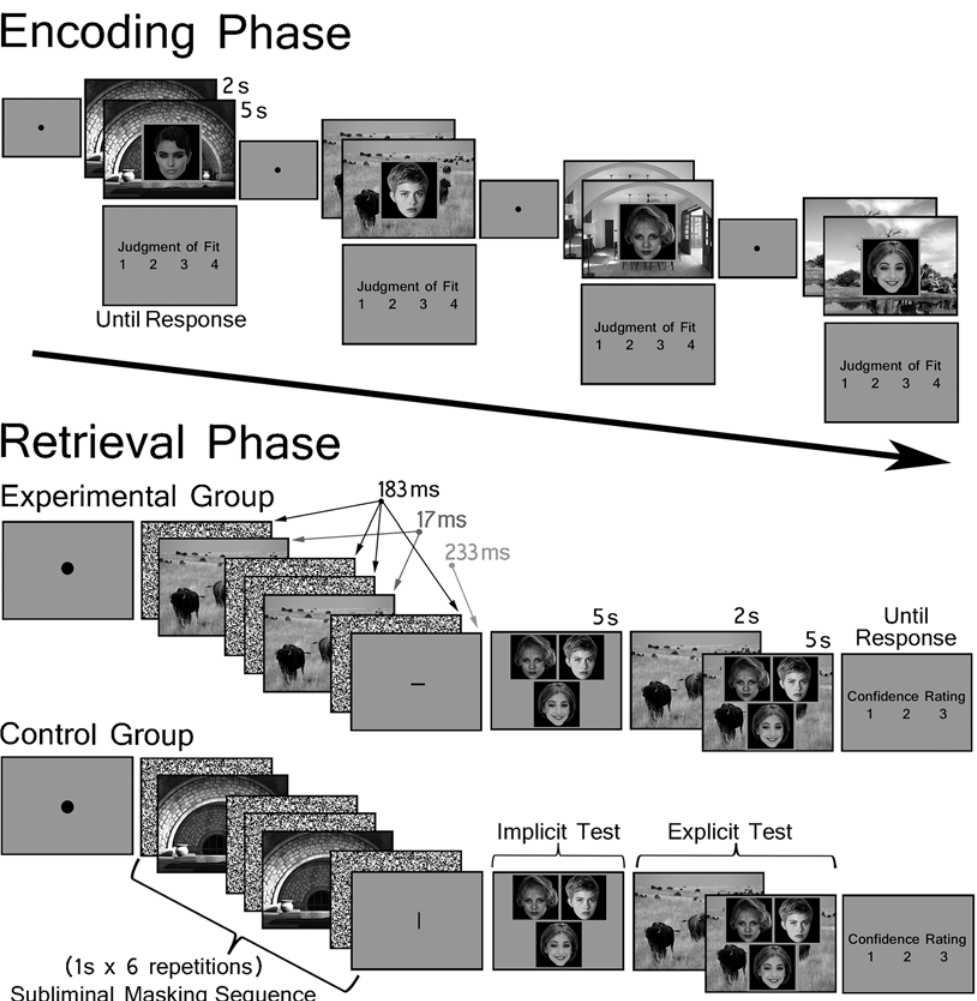
Fig 2. Encoding and Retrieval Trials. (top) Scenes were presented alone for 2 seconds at the start of each encoding trial. A face was then superimposed on the scene for 5 seconds and participants were instructed to indicate whether the pair was a good fit using a scale from 1 – 4. There was no time limit imposed on the judgment. (bottom) Each test trial began with the subliminal presentation of a studied scene. The scene was embedded in a masking sequence and participants were instructed to perform an attention task – making a button press when a visible fixation cross was replaced with a vertical or horizontal line segment. The masking sequence shown here was repeated six times, which meant that the scene was presented twelve times in 6 seconds. Following subliminal presentation of the scene, a visible three-face display was presented for 5 seconds and was used to test memory implicitly. At the end of the trial, a visible scene cue (2 seconds) preceded presentation of the same 3-face test display (5 seconds), which was used to test memory explicitly. Controls were yoked to experimental participants so that all of the trial events were the same with the exception of the subliminal scene cue, for which there was not an associate in the corresponding implicit test